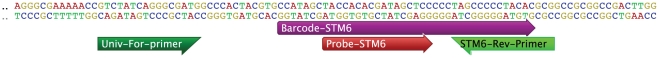
CIp30-STM6 detection.Details of the CIp30 plasmid sequence, in which the barcode (here STM6) was cloned between DraIII and NotI restriction sites. The localization of the STM6 barcode (purple), the position where the Taqman probe specific for STM6 is hybridizing (red) and the positions of forward (dark green) and reverse primers (light green) are indicated. Note that the reverse primer hybridizes at the 3′-extremity of the barcode and thus enhances the specificity of detection.